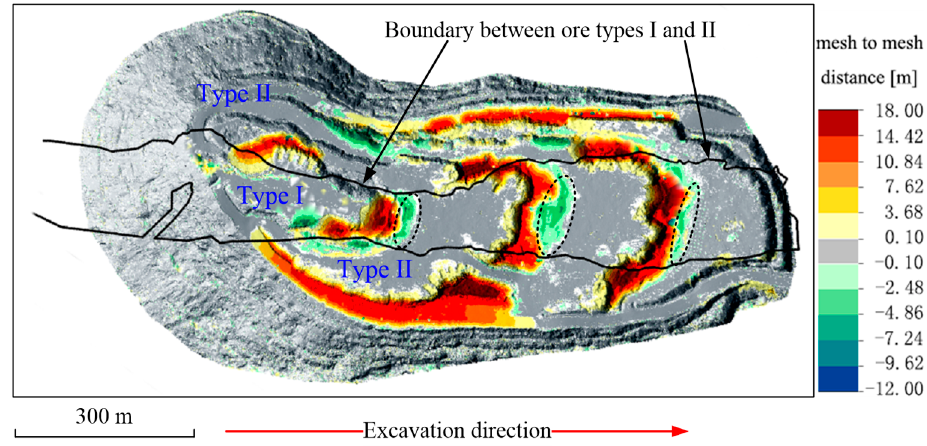
Figure 11. Distances between Digital Elevation Models (DEMs) of the registered two-temporal TLS surveys in site A calculated using the mesh-to-mesh distances. The boundary between two ore types I and II is overlapped, where type I contains Fehw, Fec, Fehp, Feh minerals and type II contains Fepp, Me, Lph, Chq, Am, Cs. The dotted circles indicate the regions with negative values from the distance map. Table 4. Comparison on the accuracy of measuring exploitative quantity, achieved by our method and in-situ data in site A.